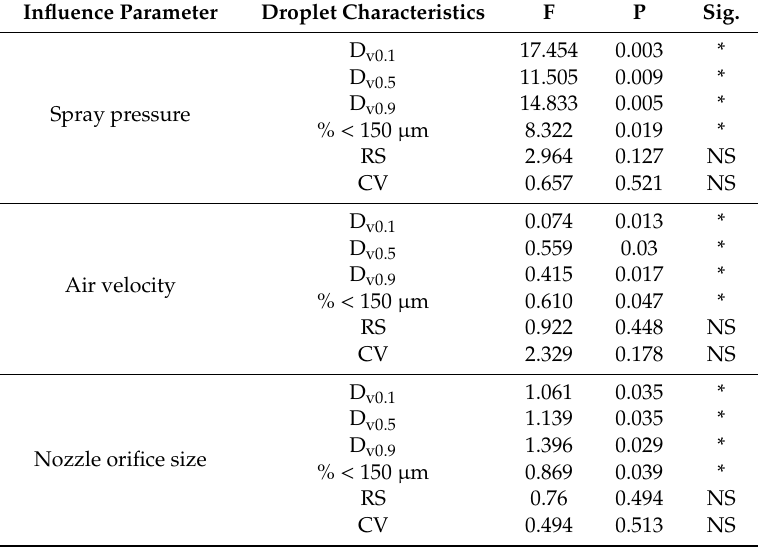
Table 4. The influence of parameters on droplet characteristics after ANCOVA. F: Variance of the group mean; p -value: The probability of obtaining the observed results; NS: Not significant, and *: Significant. Influence